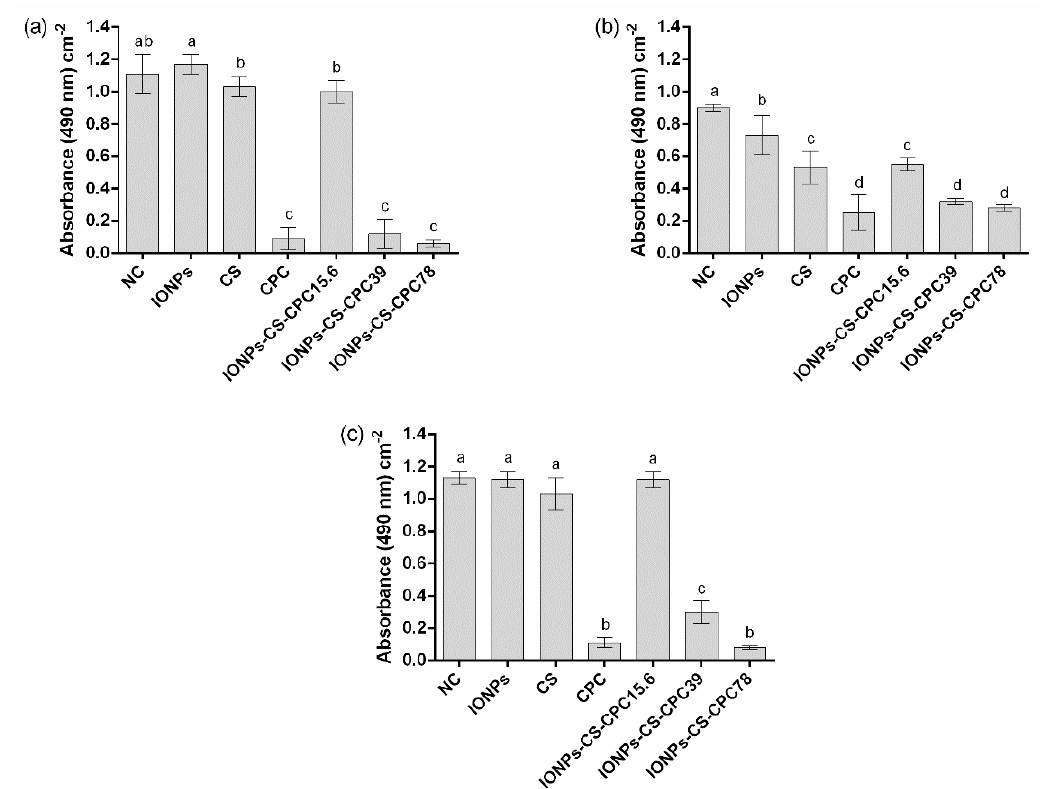
Figure 5. Quantification of biofilm metabolic activity by XTT reduction assay. Mean absorbance values per cm 2 for single biofilms of Candida albicans ATCC 10231 ( a ), Candida glabrata ATCC 90030 ( b ), and dual-species biofilms ( c ) treated with 54.6 µ g mL − 1 iron oxide nanoparticles (IONPs), 54.6 µ g mL − 1 chitosan (CS), 78 µ g mL − 1 cetylpyridinium chloride (CPC) and nanocarrier containing CPC at 15.6 (IONPs-CS-CPC15.6), 39 (IONPs-CS-CPC39) and 78 µ g mL − 1 (IONPs-CS-CPC78). Negative control (NC) indicates biofilms treated with pure artificial saliva (without drugs). Error bars represent standard deviations of the means. Di ff erent lower case letters indicate significant di ff erences among the groups by one-way ANOVA and Fisher LSD’s test ( p < 0.05).